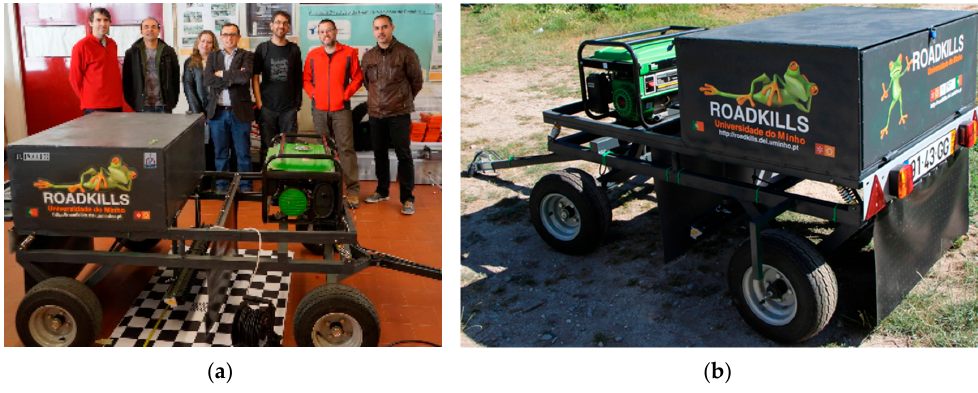
Figure 1. Developed road scanning trailer: ( a ) Prototype and project team; ( b ) Prototype